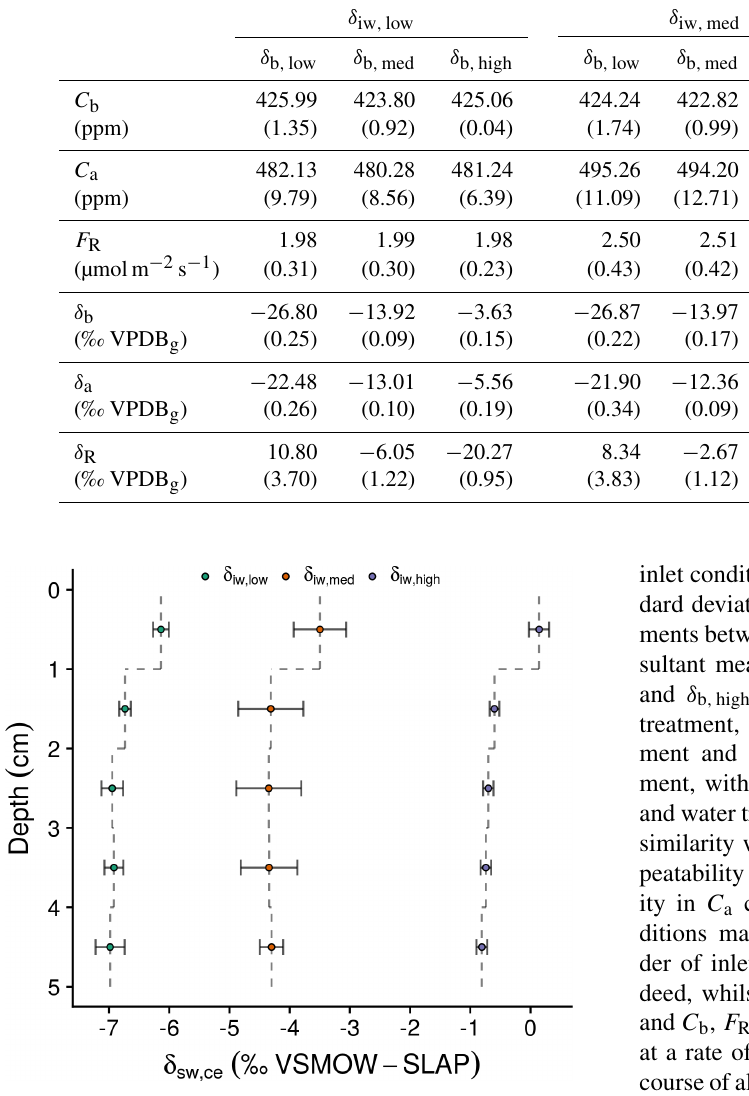
Figure 3. Incubation depth profiles of the δ 18 O of cryogenically extracted soil water ( δ sw , ce ), at intervals of 0–1, 1–2, 2–3 and 4– 5cm below the surface. Symbols and error bars indicate means and standard deviations by irrigation water ( δ iw ) treatment and depth